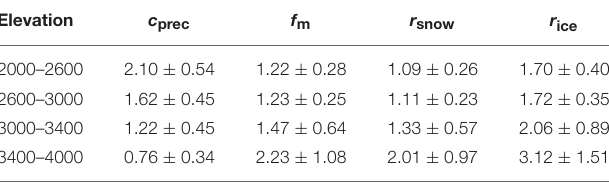
TABLE 1 | Most important parameters of the model calibrated to each individual glacier.